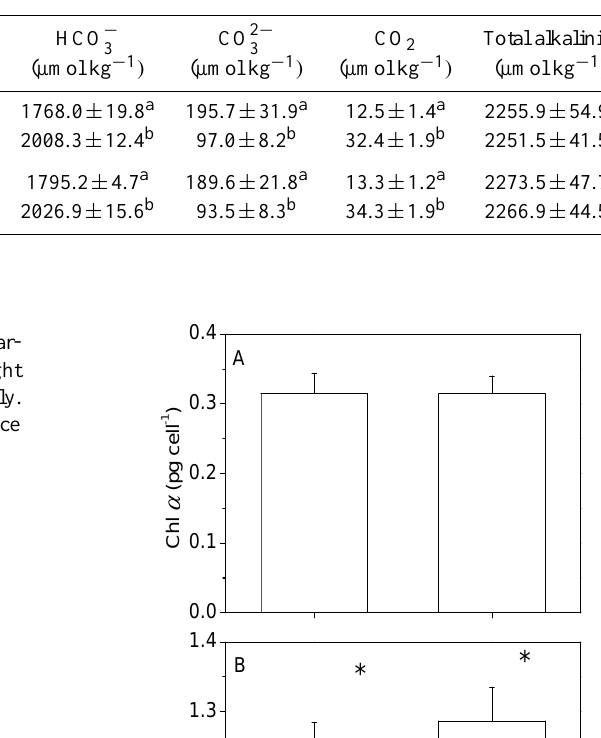
Table 1. Parameters of the seawater carbonate system under the ambient (39.3Pa) and enriched (101.3Pa) CO 2 levels before and after the partial renewal of the medium for the semi-continuous cultures. Dissolved inorganic carbon (DIC), pH, salinity, nutrient concentration, and temperature were used to derive all other parameters using a CO 2 system analyzing software (CO2SYS). Data are the means ± SD of 9 measurements, the superscripts represent significant difference between ambient and enriched CO 2 .